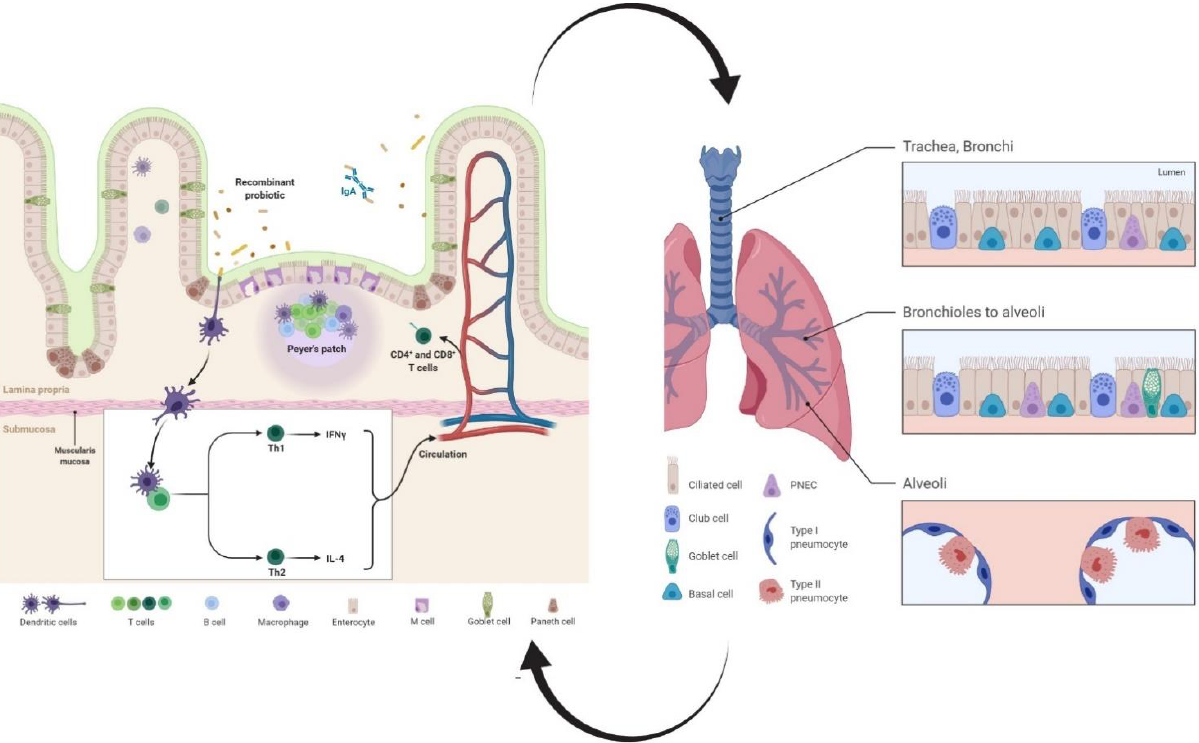
Figure 3. Schematic representation of the stimulation of immune responses with genetically modified probiotics expressing therapeutic factors in the gut and the lung. The crosstalk and the reciprocal interaction of the gut and lung mucosa (gut-lung axis) is mediated by immune cells moving between the two districts via the bloodstream and the lymphatic ducts, leading to modulation of the immune response in both sites. Delivery of antigen via recombinant probiotic to antigen-presenting cells in Peyer’s patches causes the stimulation of naive B and T cells and induction of several immune factors, such as Th1 and Th2 cytokines. As a result, cells and immune factors migrate to the thoracic duct and the BALT through circulation and enhance the production of secretory IgA and the activation of effector CD4 + and CD8 + T cells, preventing the onset and progression of respiratory viral infections. IgA, immunoglobulin A, IL-4: interleukin-4, IFN-γ: interferon-gamma, Th1: T-helper cell type 1, Th2: T-helper cell type 2, BALT: bronchi-associated lymphoid tissue (adapted from https://app.biorender.com/biorender-templates (access date: 24 November 2020).